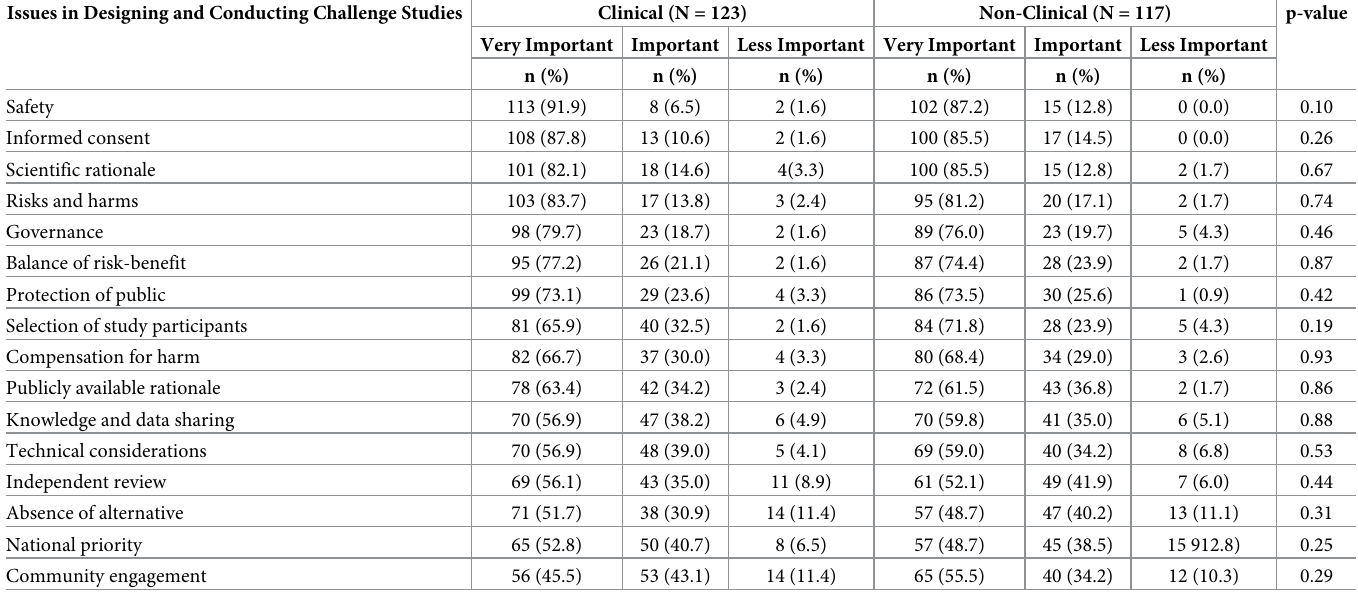
Table 3. Comparisons of ratings about challenge studies by clinical and non-clinical researchers.